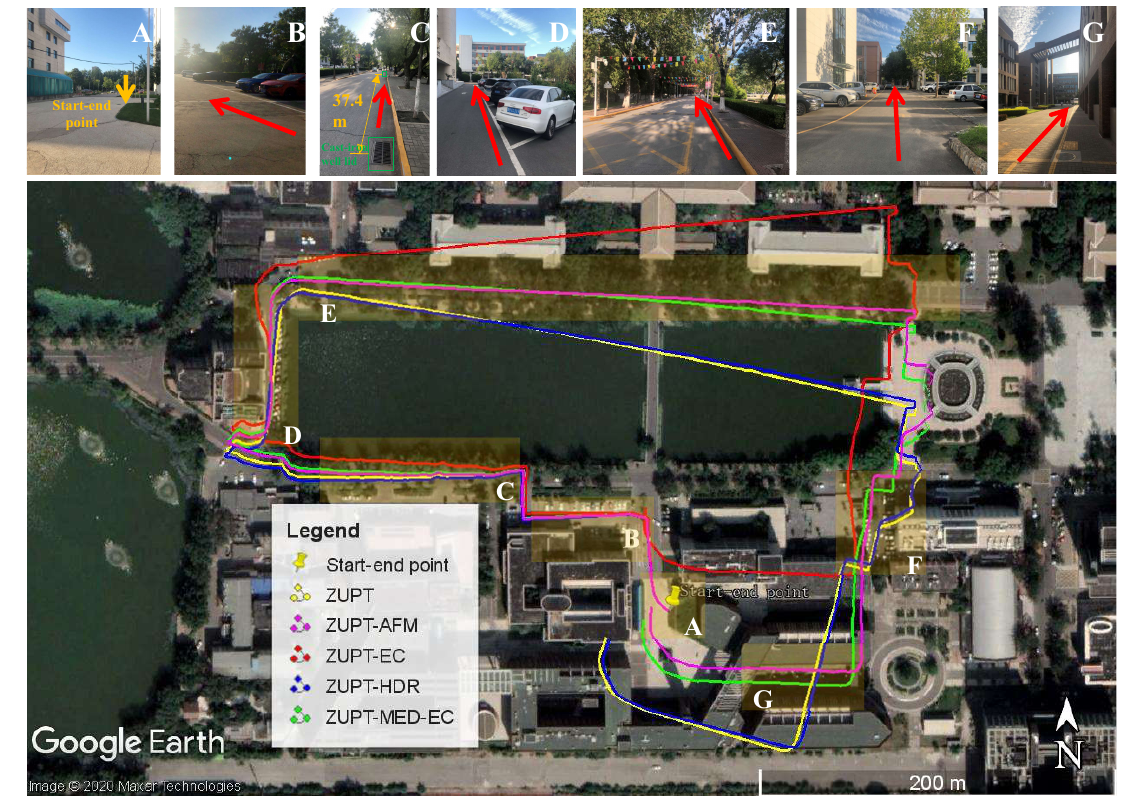
Figure 13. Estimated trajectories of the different frameworks on the outdoor dataset. Subfigures A – G show different environments in this experiment. The yellow arrow in subfigure A refers to the start-end point, and the red arrows in subfigures B – G refer to moving directions. In this experiment, the test path included approximately 349 m (see subfigure E ) of a straight line, and the tester walked through three parking lots (see subfigures B , D and F ) and over several cast-iron well lids (see subfigure C ).